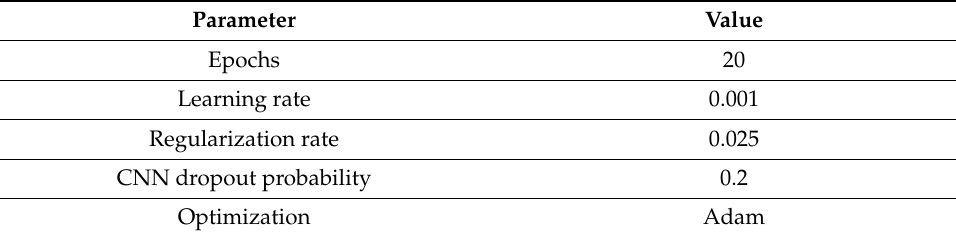
Table 5. Parameters for our